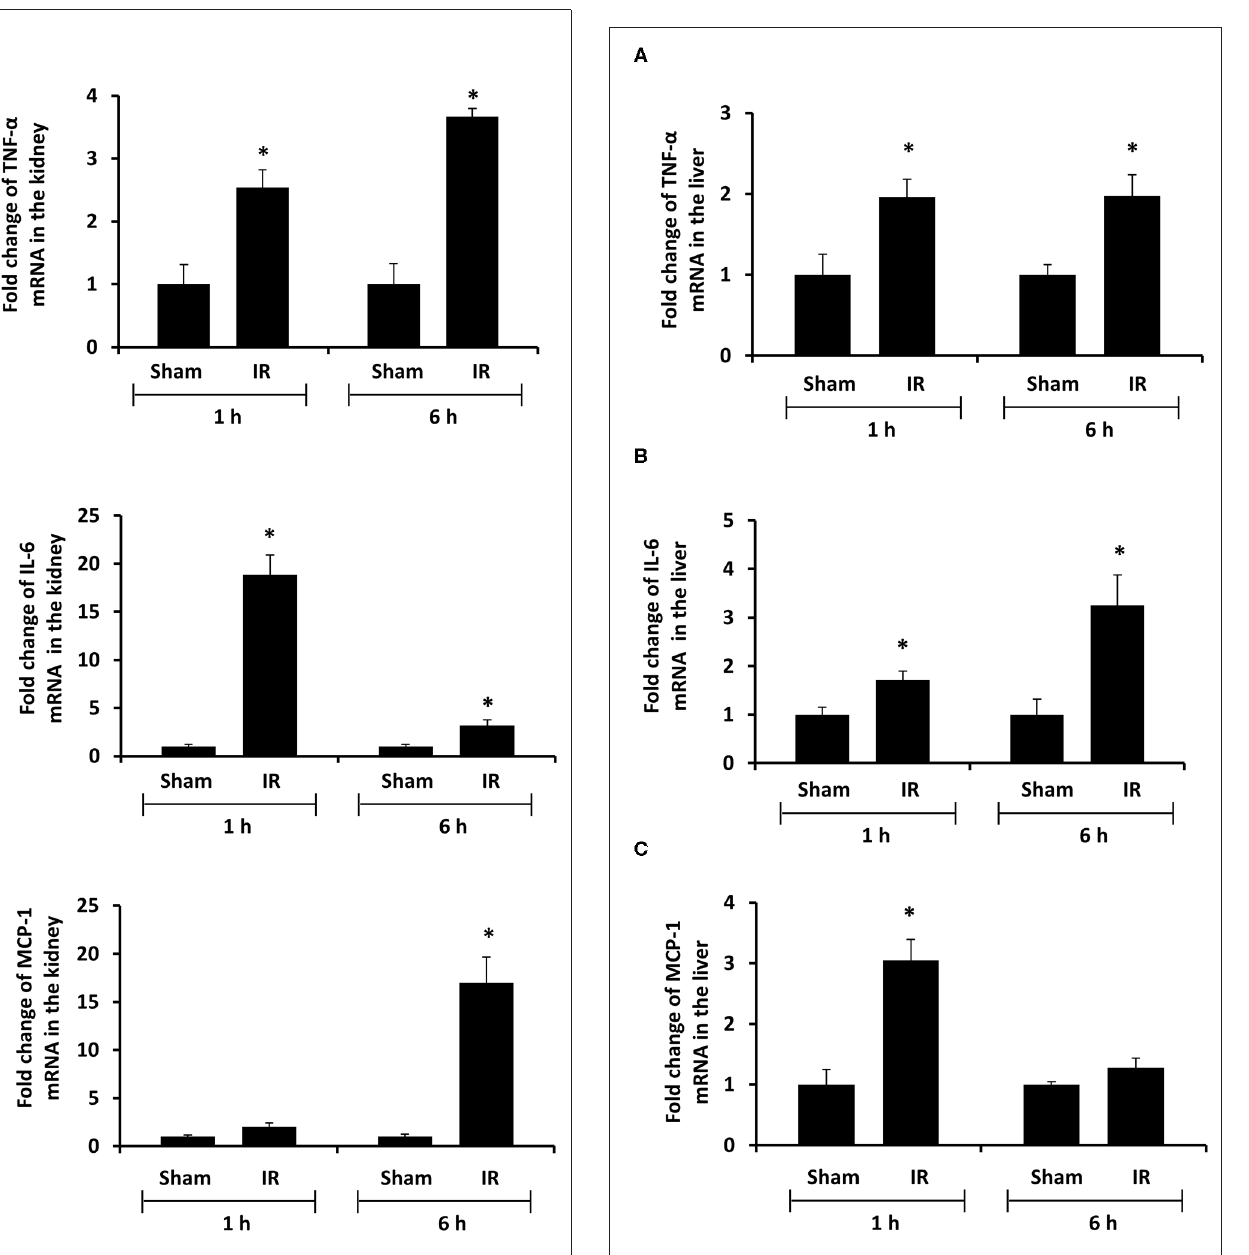
Frontiers in Medicine |